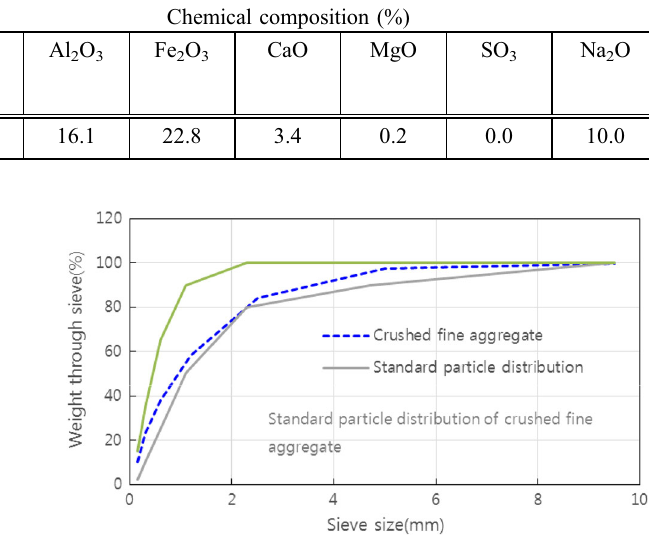
Table 2 Physical properties and chemical composition of red mud.